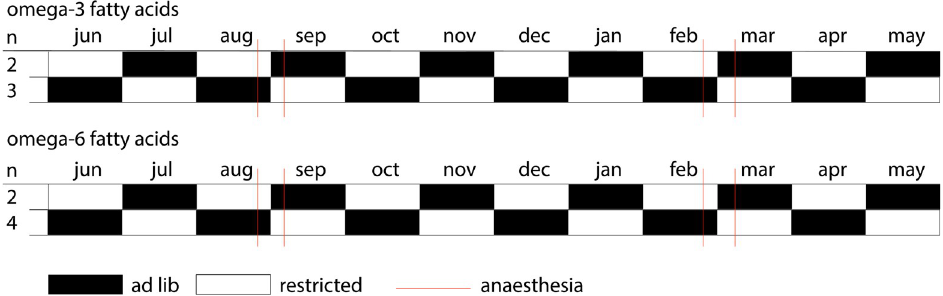
Fig 1. Experimental feeding schedule. Animals received either food pellets supplemented with omega-3 α -linolenic acid (five animals), or omega-6 linoleic acid (six animals), by immersing the pellets in 5% w/w linseed oil or sunflower seed oil, respectively. Feeding regimes alternated monthly between ad libitum (black bar) and restricted (white bar) feeding. During each season animals were anaesthetised twice (red line). Numbers in the first column (n) represent the number of animals assigned to a feeding